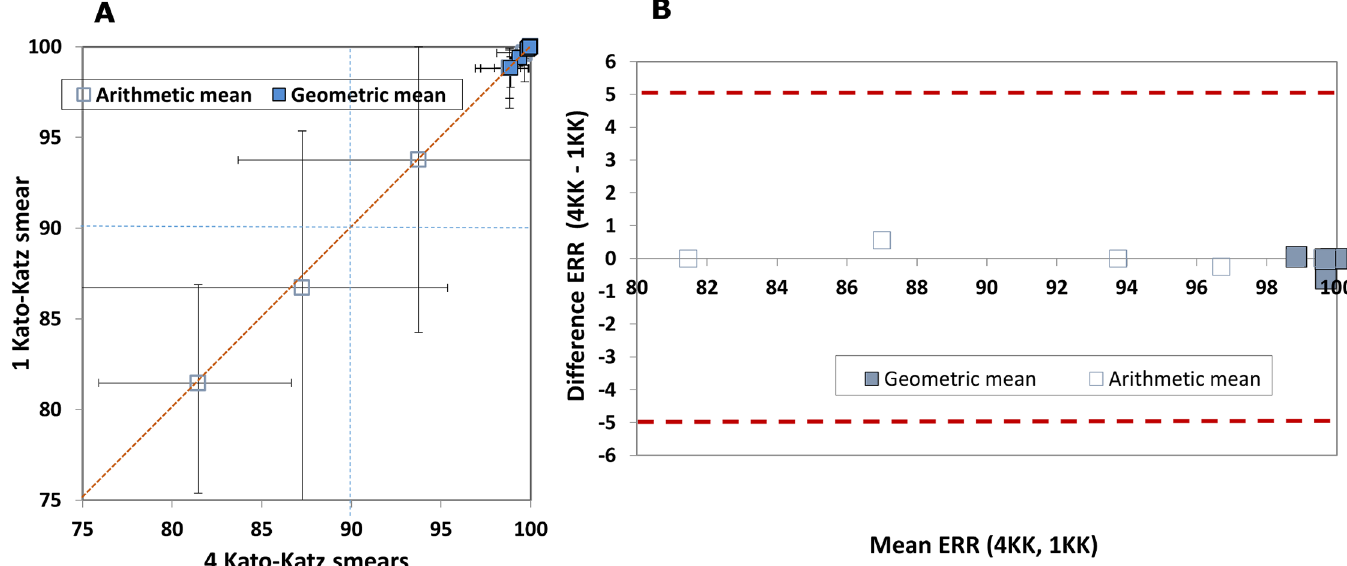
Fig 6. Comparison of egg reduction rate (ERR) calculated from a single versus quadruplicate Kato-Katz thick smears, both with estimated 95% confidence intervals (CIs). A. L ’ Abbé plot. For each point, the 95% CIs are shown. The red dashed diagonal line of no difference between the ERR calculated with both metrics. The blue dashed line represents the threshold for acceptable efficacy defined by the WHO [3]. B. Bland-Altman plot. The red dashed lines show the interval that determines the agreement of the two metrics, set at 5%. The blue dashed line represents the threshold for acceptable efficacy defined by the WHO